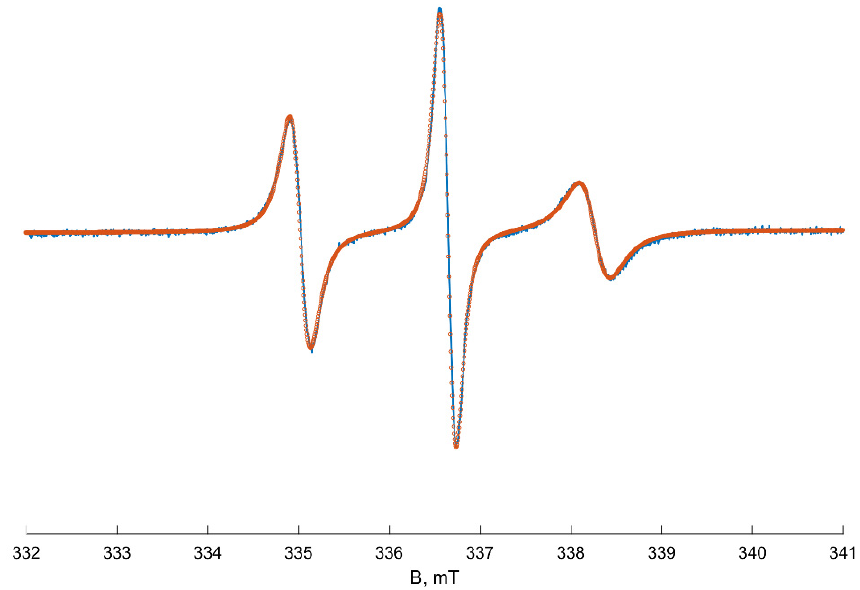
Figure 3. EPR spectrum of TEMPO radical in PNIPAM solution at 353 K in the presence of Cu(II) ions. Blue line—experimental spectrum, red dots—simulated spectrum.